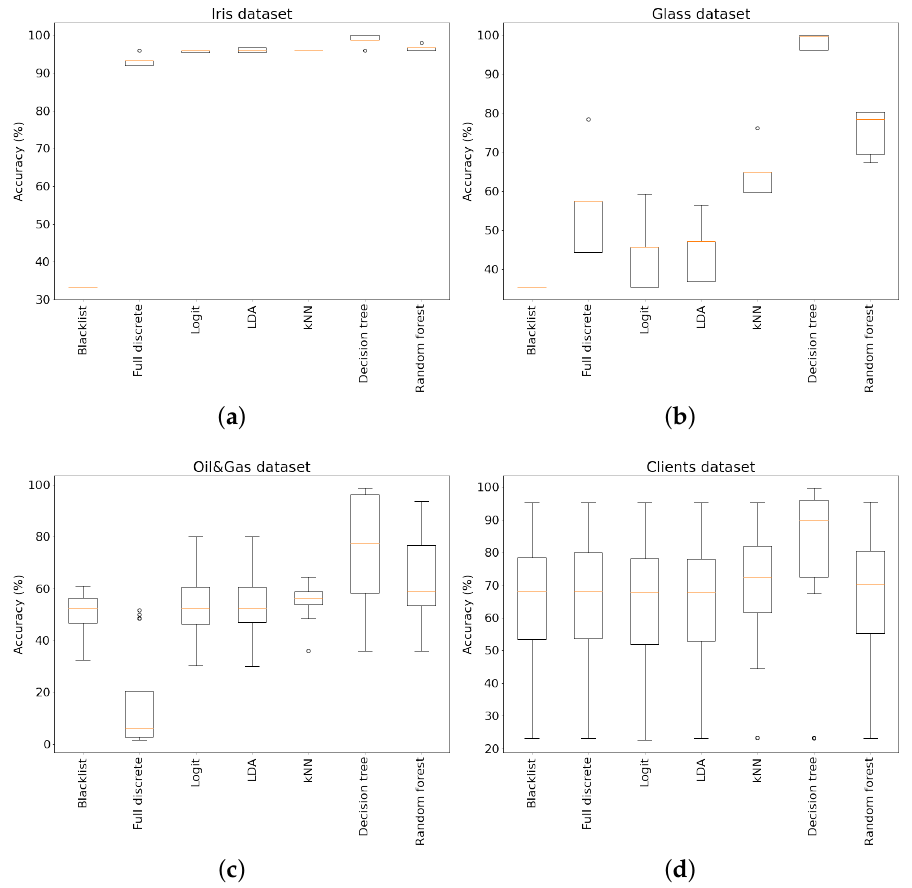
Figure 8. Experimental results comparing the quality of recovery in terms of accuracy of discrete variables for a classical network with prohibition of continuous parents for discrete children (Blacklist), for networks without prohibition but with discretization of continuous (Full discrete) and for different classifiers as ways of parametric description of dependencies. For Iris ( a ), Glass ( b ), Reservoir ( c ) and Clients ( d ) datasets. The closer the accuracy to 100 percent, the better the